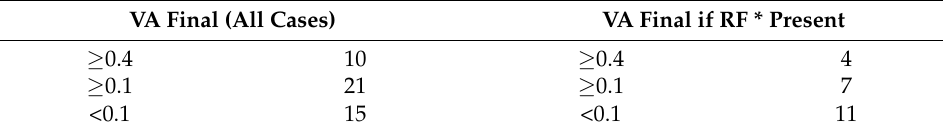
Table 2. Visual outcomes at the last